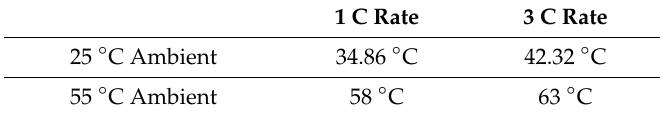
Table 9. Cell temperature when discharged at di ff erent C rate under two ambient